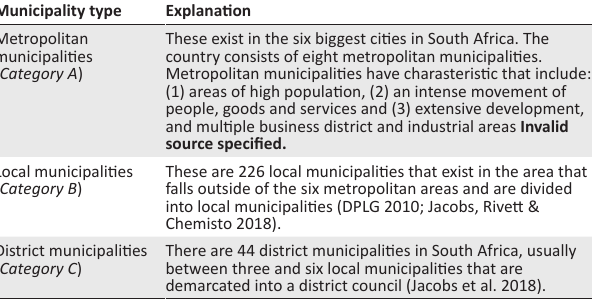
TABLE 1: Types of municipalities in South